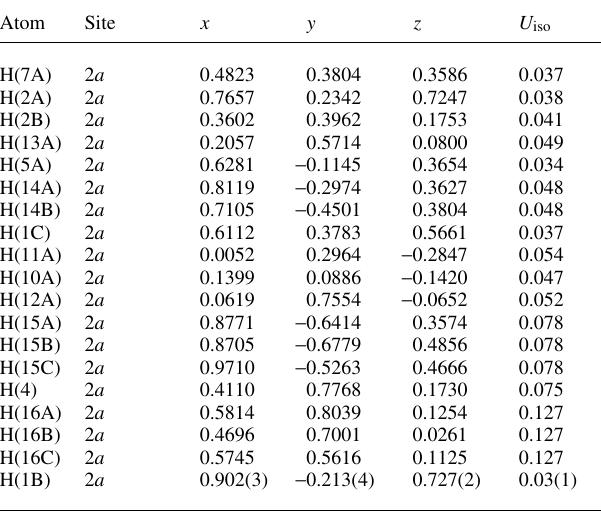
Table 2. Atomic coordinates and displacement parameters (in Å 2 )